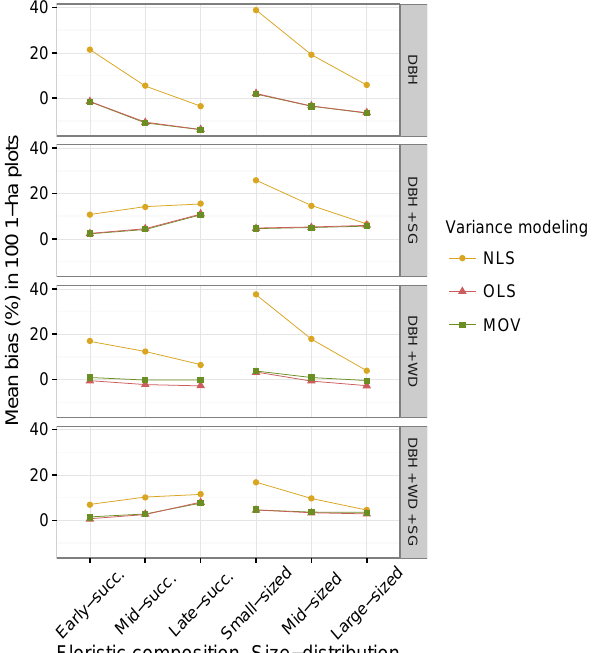
Figure 5. Profiles relating the root-mean-square error of 12 above- ground tree biomass estimation models tested along six forest sce- narios composed of 100 1ha plots. Forest scenarios were designed to reflect landscape-level variations in floristic composition and size distribution of trees, typical of central Amazonian terra firme forests. Models’ predictors: diameter at breast height (DBH) (cm), species’ successional group (SG) (pioneers, mid- and late succes- sional) and wood density (WD) (gcm − 3 ) . Variance modeling ap- proaches: nonlinear least square (NLS), ordinary least square with log-linear regression (OLS) and nonlinear with modeled variance (MOV). Note that models containing tree total height ( H ) as pre- dictor were excluded